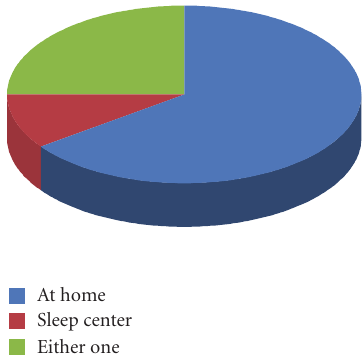
Figure 6: Chart of preference for home monitoring or sleep center.